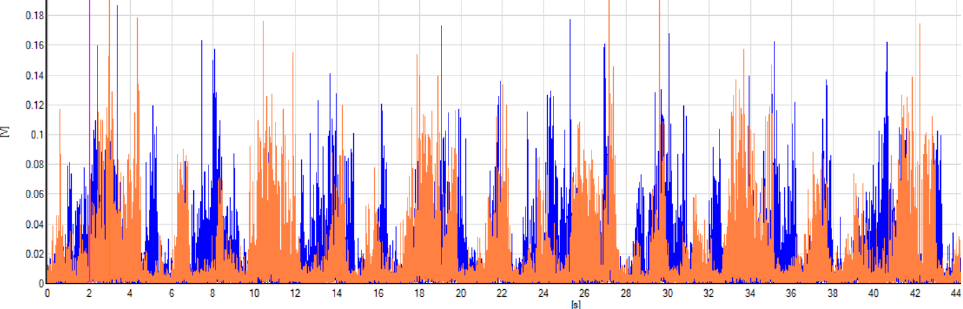
Figure 6. Synchronization of the two